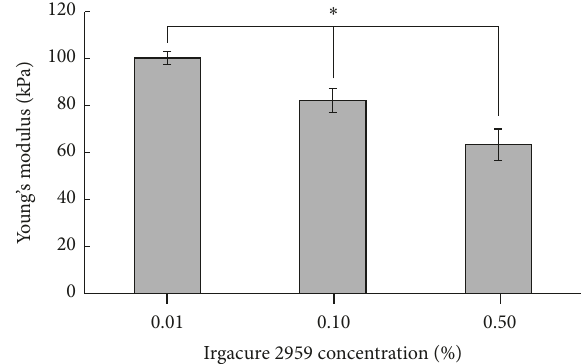
Figure 4: Young’s modulus as a function of photoinitiator Irgacure 2959 concentration for A12-B.25 PAA hydrogel for a fixed UV intensity of 15 mW/cm 2 and fixed exposure time of 300 s. Asterisks designate significant differences for 𝑝 < 0.05 , 𝑛 = 3 . Figure 5: Young’s modulus of two PAA hydrogel compositions as a